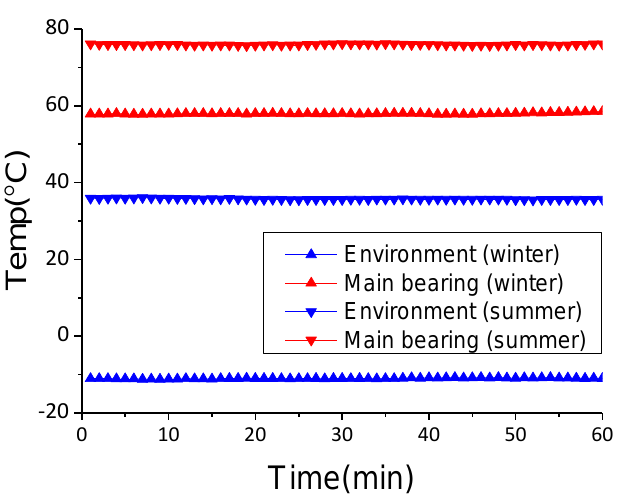
Figure 3. Main bearing temperature within different ambient temperatures.